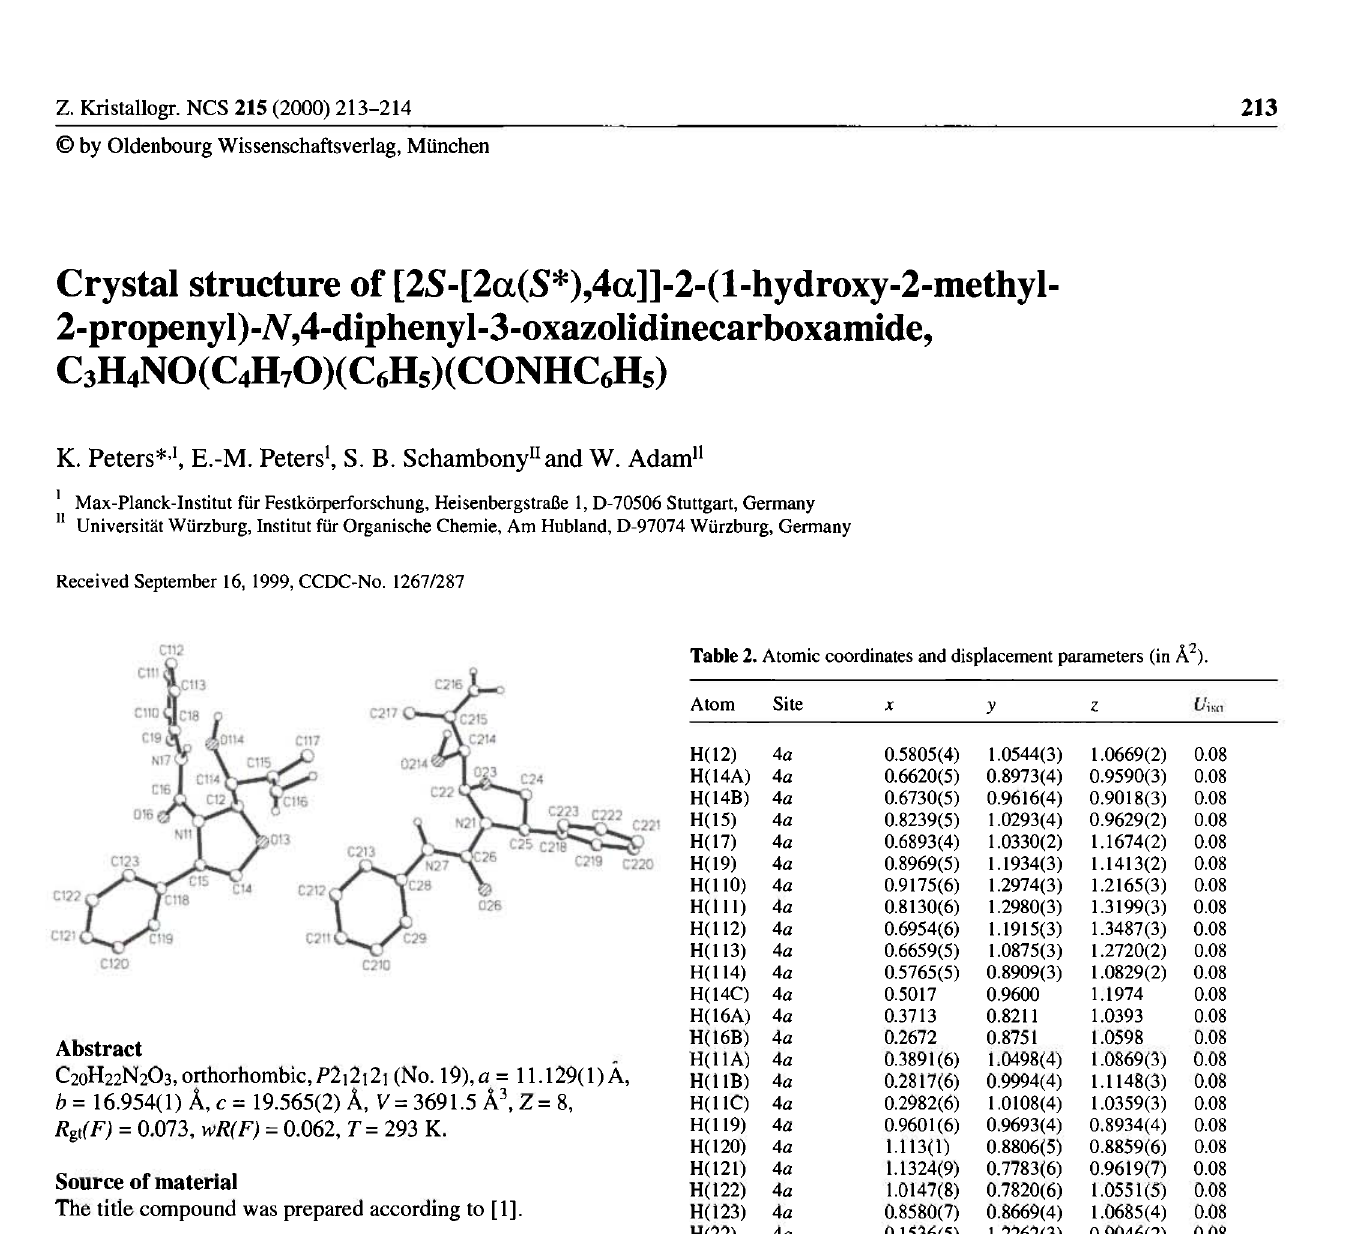
Table 1. Data collection and